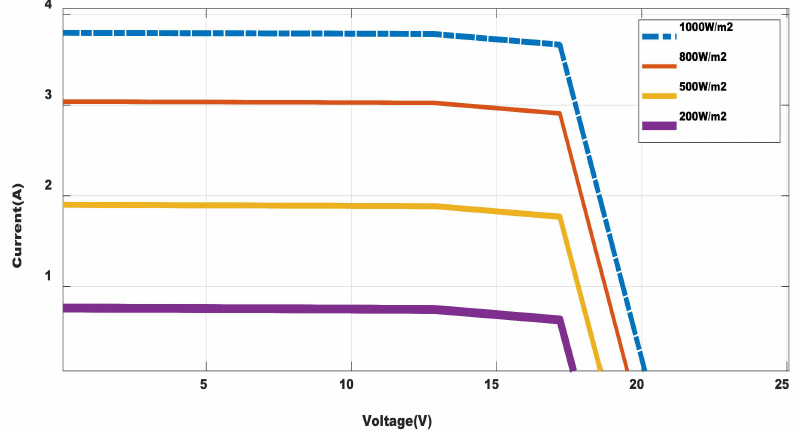
Figure 2. I–V output characteristics of PV model at fixed temperature of 25 degree.